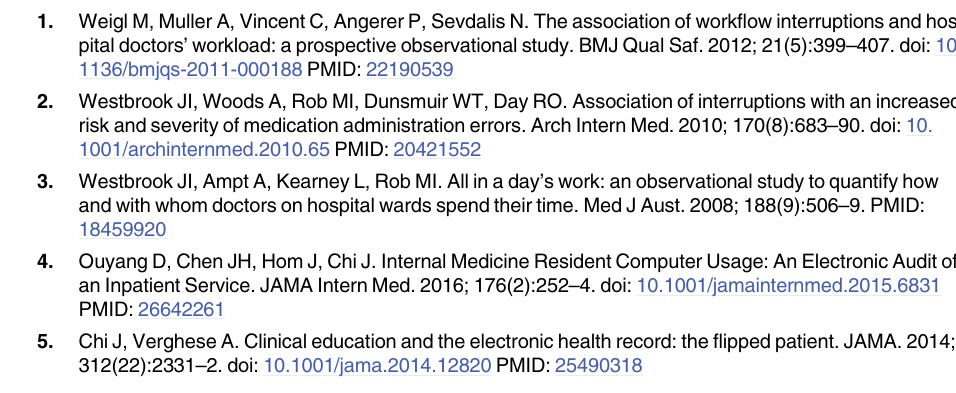
S1 Table. Definitions of the 22 resident’s activities grouped in six categories. Activities of residents are exclusive. EHR = electronic health